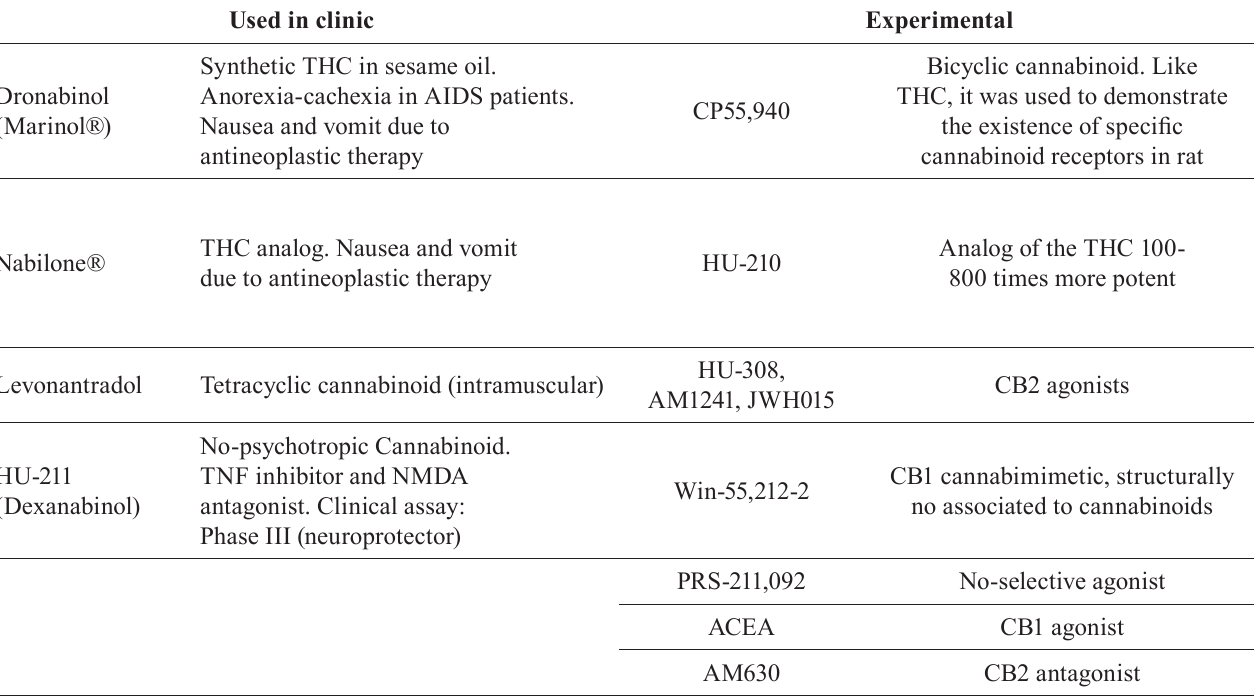
TABLE IV - Pharmacological action associated with some synthetic cannabinoids used in clinics and experimentally (Modified from FICF,